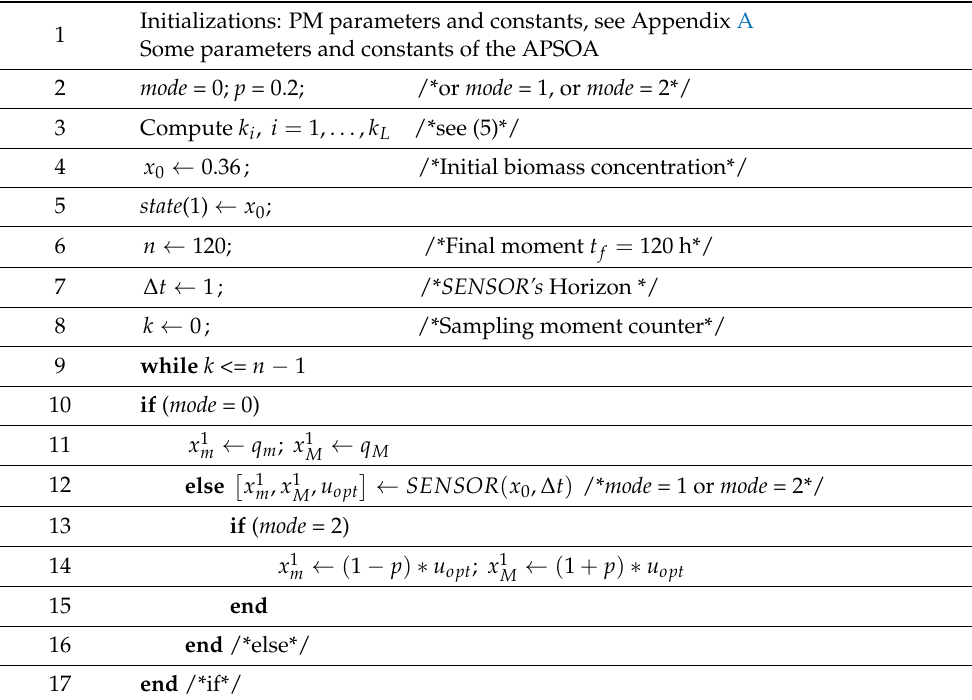
Table 4. Closed-loop simulation—description of RHC_Closed_Loop